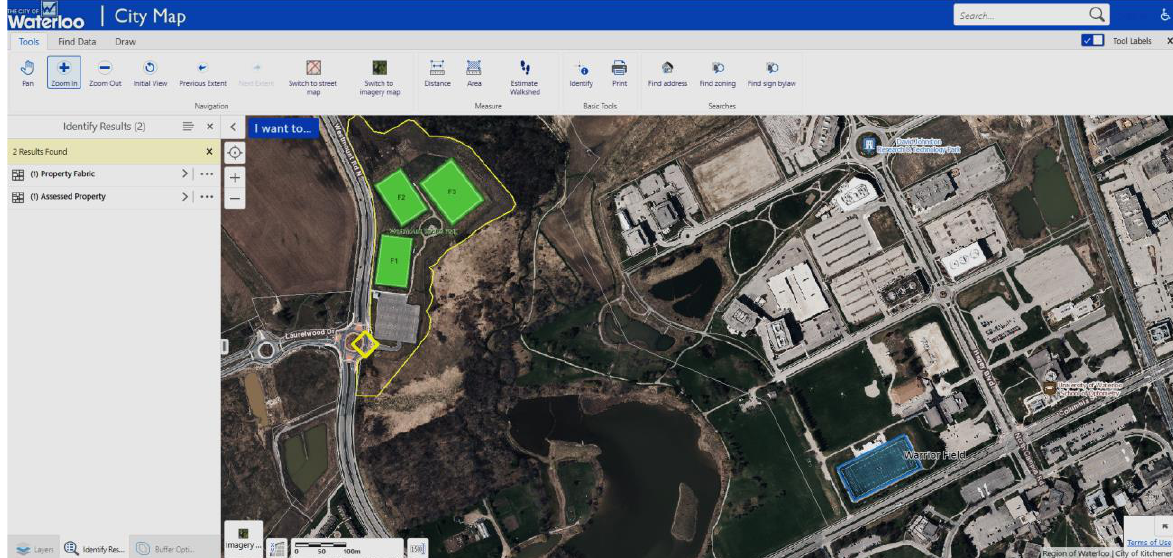
Figure 2: The interactive mapping platform of the City of Waterloo. The green rectangles are the sports fields from the city database while the blue rectangle is a relatively new sports field that is not in the same database but drawn with the tools from the